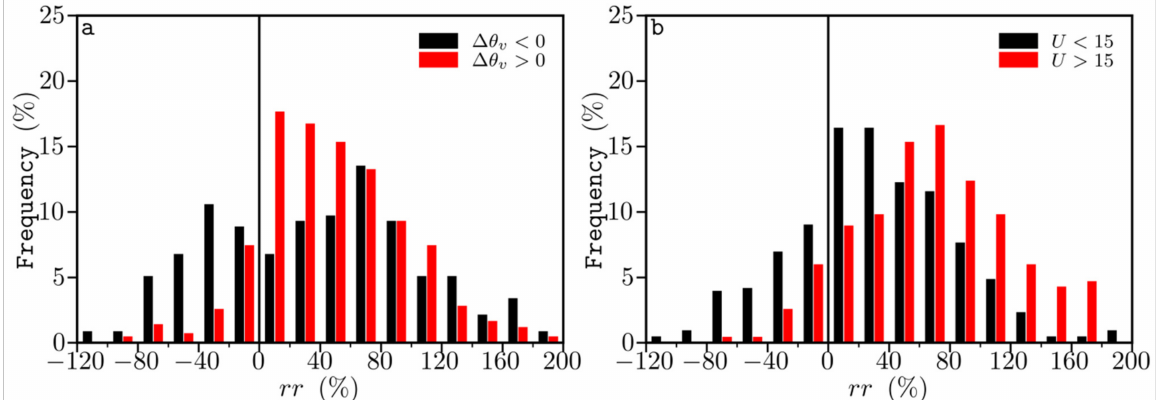
Figure 7. ( a ) Frequency distribution (%) of the KCM mod algorithm and u cor ∗ symmetrically normalized relative residuals, rr = (KCM mod - u cor ∗ )/ (KCM mod · u cor ∗ ) 1/2 , for ∆ θ v < 0 (black bar) and ∆ θ v > 0 ◦ C (red bar). ( b ) As in Figure 7a, but for U < 15 (black bar) and U > 15 m/s (red